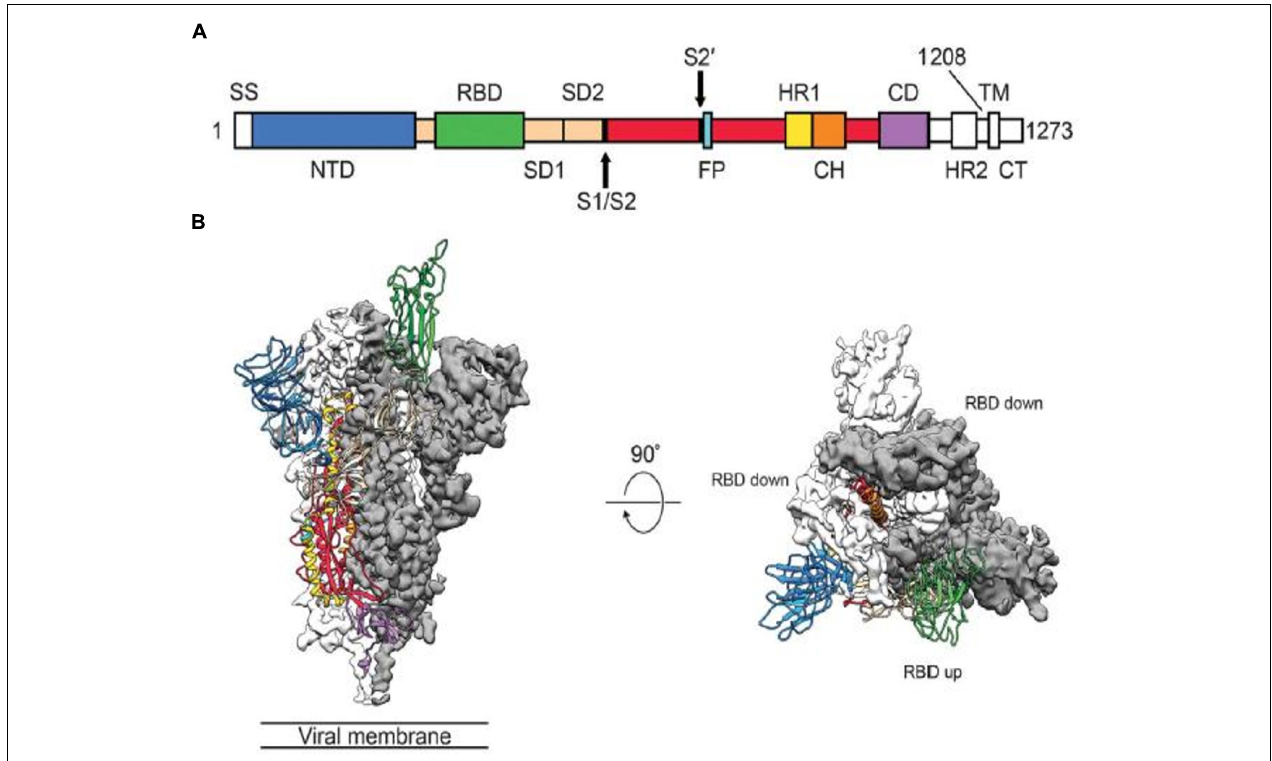
FIGURE 1 | Structure of the SARS-CoV-2 Spike Protein in the Prefusion Conformation. (A) Structures of the SARS-CoV-2 Spike Protein. SS, signal sequence; S2’, S2’ protease cleavage site; FP, fusion peptide; HR1, heptad repeat 1; CH, central helix; CD, connector domain; HR2, heptad repead 2; TM, transmembrane domain; CT, cytoplasmic tail; NTD, N-terminal domain. Arrows indicate protease cleavage sites; RBD, receptor binding domain. (B) The Prefusion Conformation of the SARS-CoV-2 Spike Protein. To engage a host cell receptor, the RBD undergoes hinge-like conformational movement. Down conformation corresponds to the receptor-inaccessible state and up corresponds to the receptor accessible state. Modified from Wrapp et al.